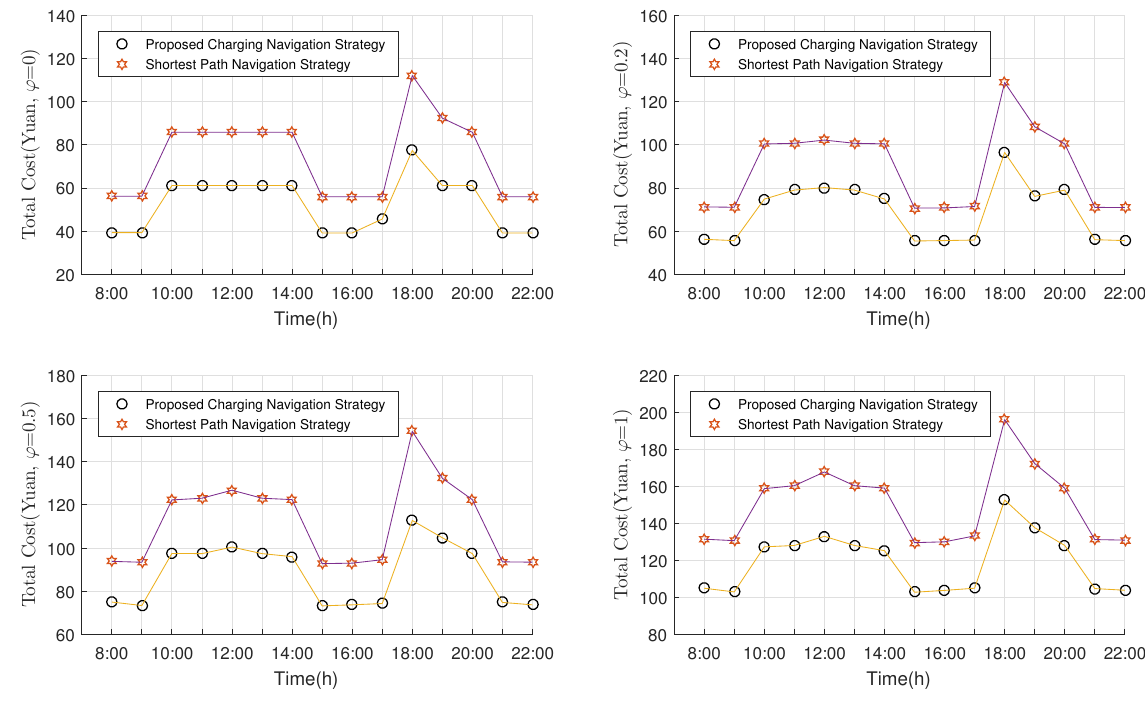
Figure 11. Total cost comparison of two different navigation